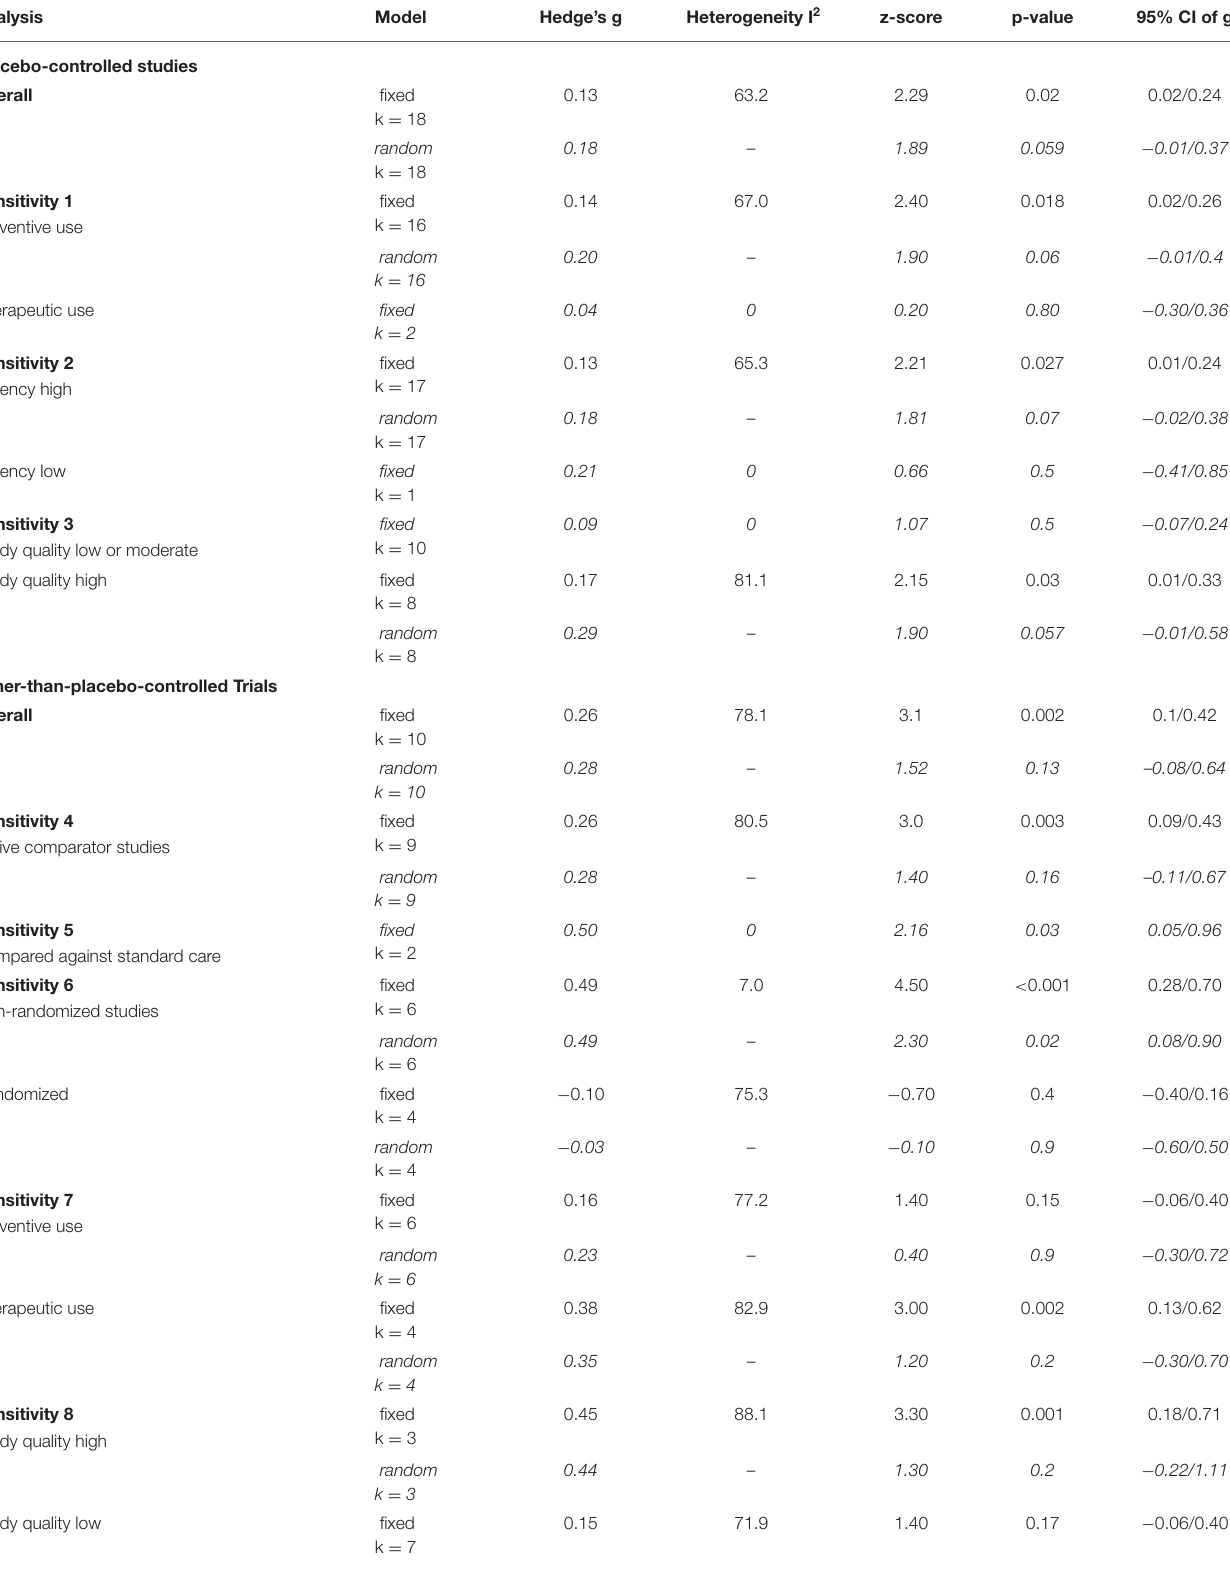
TABLE 2 | Summary of